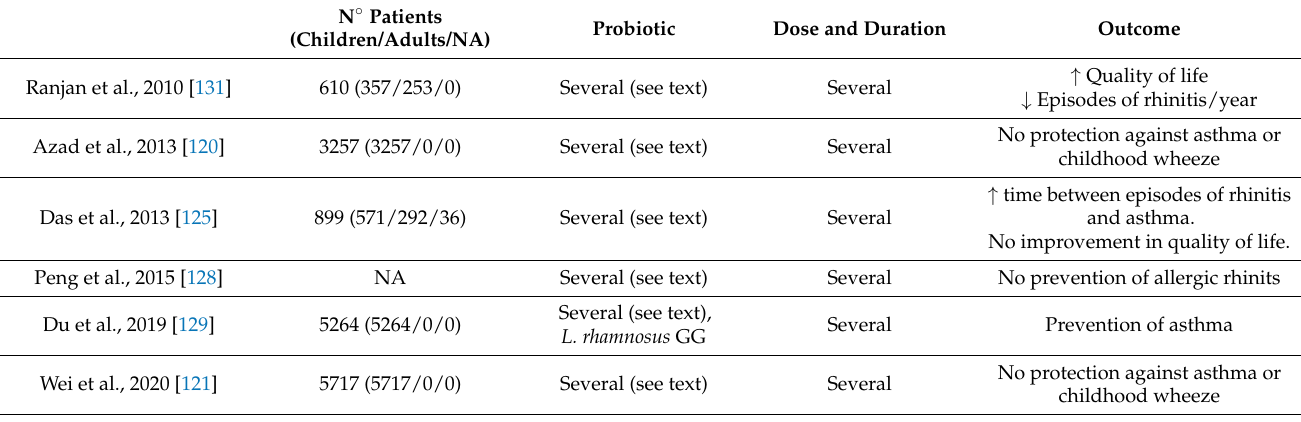
Table 15. Meta-analyses and systematic reviews on probiotics in asthma and allergic